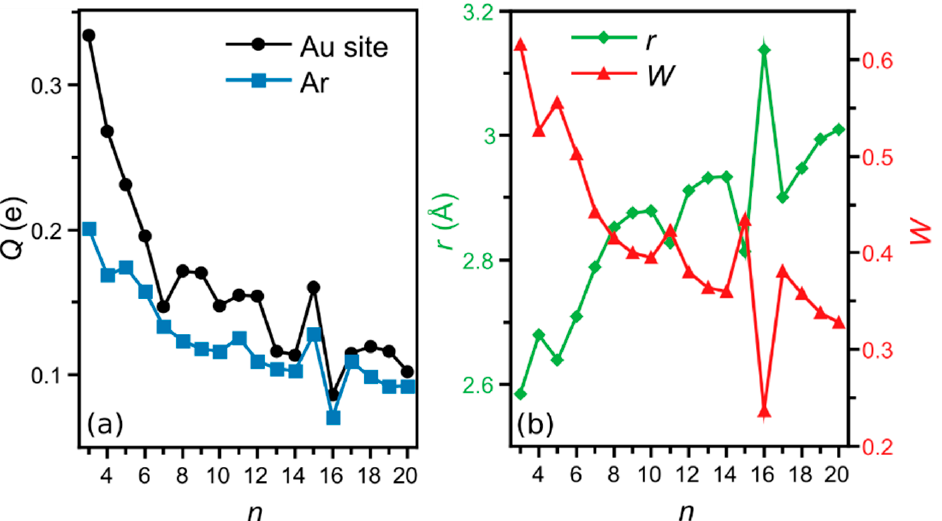
Figure 5. ( a ) Hirshfeld partial charge of the Au adsorption site of the bare Au n + cluster (black circle), and Ar (blue square) in the Au n Ar + complex. ( b ) Bond length ( r —green diamonds) and Wiberg index ( W —red triangles) of the Au n − Ar + bond as a function of the cluster size n . The bonding between Au n + and Ar is further analyzed by calculating the Wiberg index ( W ) of the Au n + -Ar bond (structures in Figure 2), as presented in panel (b) of Figure 5. In line with the amount of electron charge from Ar to Au, the W index shows an overall decrease with n . For the smallest n = 3, 4 and 5 sizes the index is above 0.5, in line with the high Ar adsorption energies (above 0.3 eV). Interestingly, the Wiberg index has local maxima at Au 11+ and Au 15+ and a pronounced minimum at Au 16+ . The correlation between the partial positive charge of Ar and the Wiberg indices, together with the W values themselves being relatively large, in particular for n ≤ 5, reflects the formation of a chemical bond between Au n + and Ar with a partial covalent character. A higher W index correlates perfectly with a smaller bond distance between Au and Ar in Au n Ar + , as shown in Figure 5b. The density of states (DOS) of three selected clusters are presented in Figure 6: Au 3 Ar + , Au 15 Ar + and Au 16 Ar + . In each case, the DOS was projected onto the states of the Au adsorption site and of Ar. For Au 3 Ar + , shown in the upper panel, there were three occupied states of major Ar character, which were highly hybridized with the states of the Au adsorption site ( − 16.4, − 15.3 and − 14.8 eV). Such overlap between the Ar and Au states clearly indicates the formation of a formal chemical bond between the atoms, in line with the high W index (0.62) for this cluster. Similar states were found in the PDOS of Au 15 Ar + (middle panel), however in this case, the hybridization was smaller, as highlighted by the smaller W index (0.44). In contrast, the hybridization between Au and Ar is minor in Au 16 Ar + , in correspondence with the close to zero W index in this case, being only 0.24. Such a small W index is a consequence of the very limited electron charge transfer from Ar to Au in Au 16 Ar + , as seen from Figure